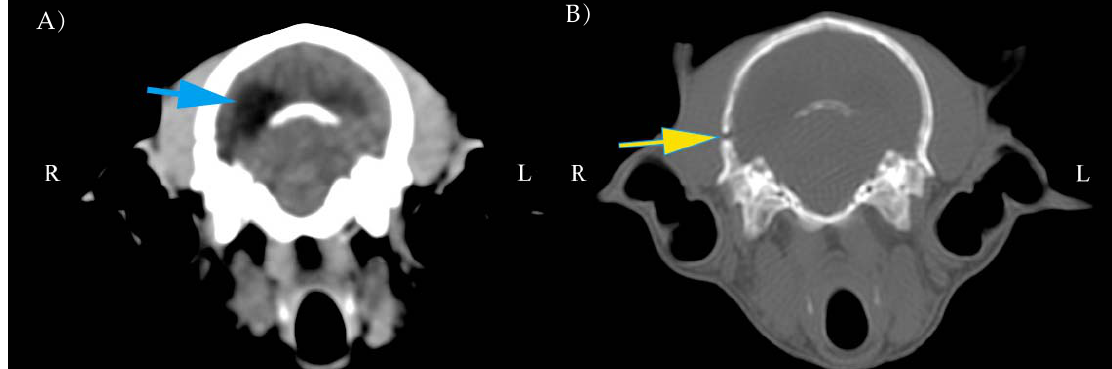
Figure 2. Representative computed tomography (CT) scans at the same position in a red fox with soft tissue reconstruction kernel and window width (WW) (100) window level (WL) (50) for the brain ( A ). Bone reconstruction kernel and WW (1500) WL (300) for bone tissue ( B ). Note the asymmetric left ventricle (blue arrow) and fracture of the cranial vault (yellow arrow) not completely repaired.